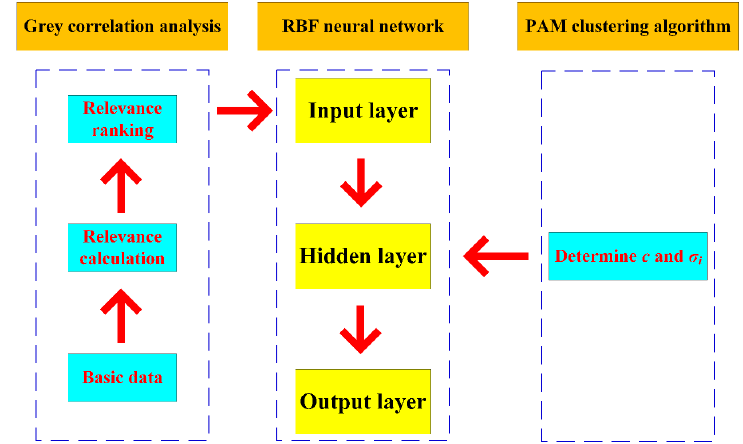
Figure 18. Improved RBF neural network.